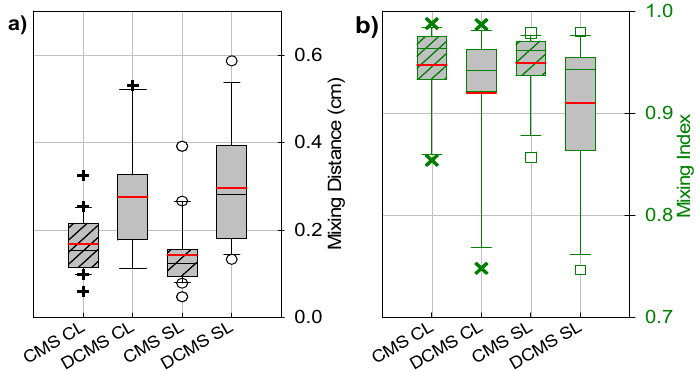
Figure 5. Boxplots depicting ( a ) a range of mixing distances required to achieve a mixing index of 0.6 (black) and ( b ) a range of mixing indices at the outlet (green) for the channel layers (CL) (black + and green × ) and surface layer (SL) (black ○ and green □ ) for the CMS (striped box) and DCMS (gray box) groups. The red and black/green lines within the boxes depict the mean and median values, respectively. The box corresponds to the interquartile range (50% of the data), whilst the lines ( ┬ ┴ ) represent 1.5× the interquartile range. The CMS data were obtained from our previous study [56].